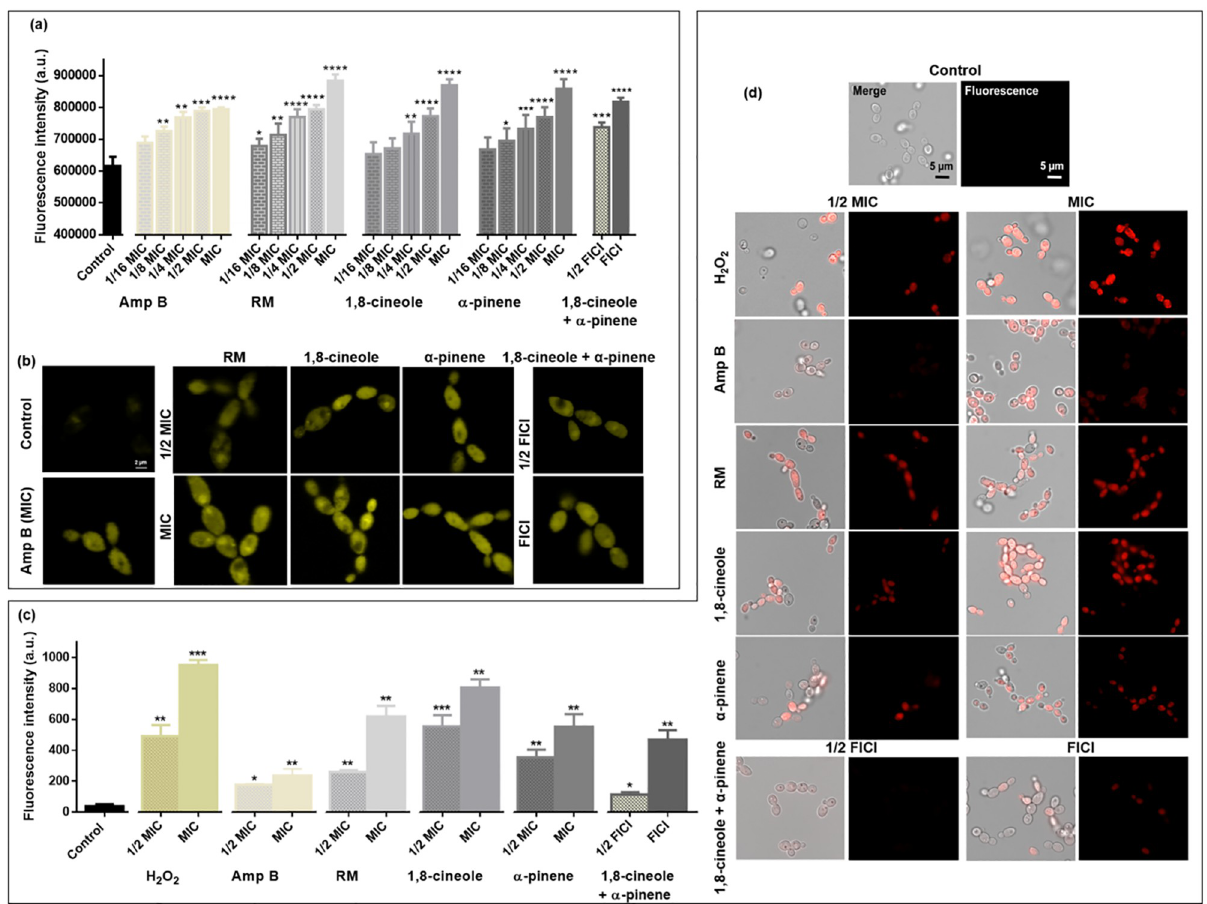
Fig 3. Effects of RM oil, 1,8-cineole and α -pinene on C . albicans RSY150 cell membrane polarization and on C . albicans RBY1132 cell membrane integrity. (a) Bar graphs show a significant ( ���� , p < 0.0001; ��� , p < 0.001; �� , p < 0.01; � , p < 0.05) increase in C . albicans RSY150 membrane depolarization with exposure to EO(C)s at MIC, 1/2 MIC and the two components at FICI, compared to the controls. Pearson correlation indicates a positive association (r = 0.96–0.99, p < 0.001–0.01) between the oil concentration (1/16, 1/8, 1/4, 1/2 MIC and MIC) and membrane depolarization. (b) LSCM images show increased dye content in treated cells compared to control. Scale bar for control is 2 μ m and represents that for all images. (c) Bar graphs show significantly ( ��� , p < 0.001; �� , p < 0.01 � , p < 0.05) higher PI uptake in oil treated C . albicans RBY1132 compared to control, with 100 cells per replicate. (d) Representative merged (bright-field/fluorescence) (left) and fluorescence (right) images ( λ ex = 493 nm; λ em = 636 nm) of treated Candida show PI uptake compared to controls. Scale bars are 5 μ m, applicable to all images. Data in bar graphs are presented as the mean ± SEM of three biological replicates, as evaluated by (a) a one-way ANOVA, followed by Dunnett’s multiple comparison of each condition versus control or (c) by an unpaired Student’s t